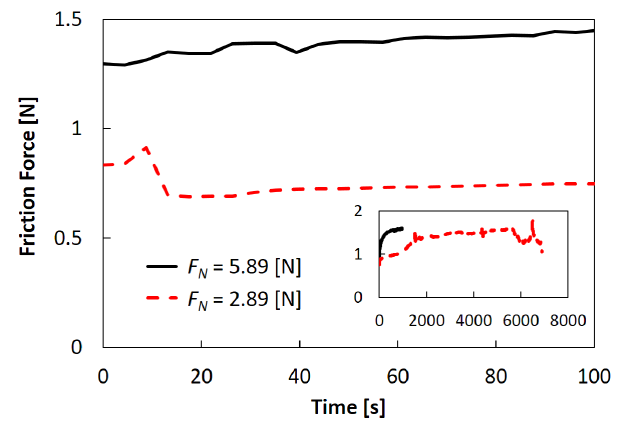
Figure 5. Time evolutions of friction forces under two different normal load conditions: F N of 5.89 N (solid line) and 2.89 N (dashed line). Main figure and inset correspond to the time evolutions of the initial 100 s and those until entire rupture of the samples. The fatigue lives were 1542 ± 938 and 4559 ± 1688 s for F N of 5.89 and 2.89 N, respectively. Piranha treatment was used for all samples.